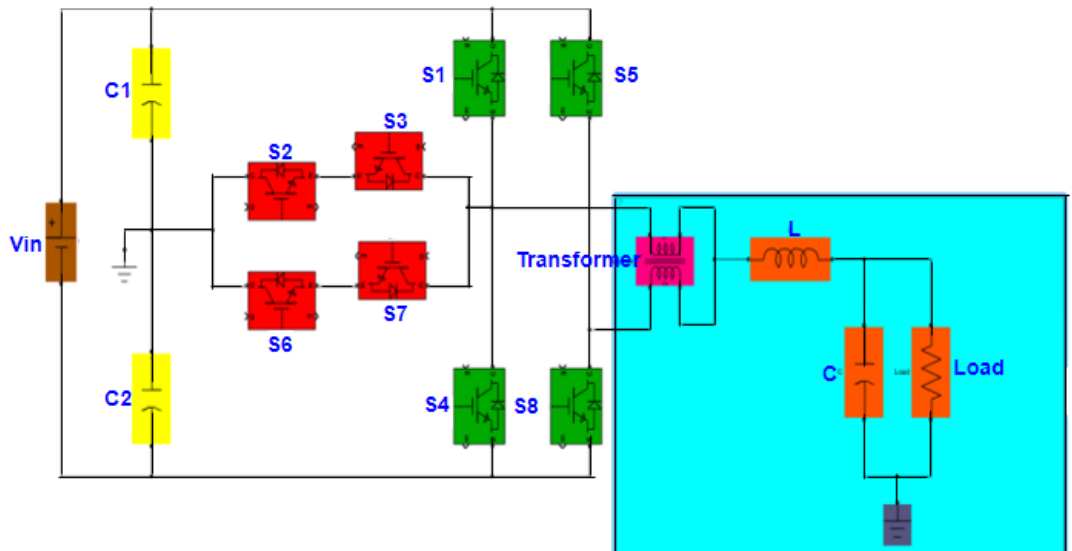
Figure 7. Modified 5 level T ‐ bridge topology.